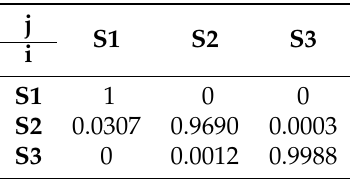
Table 2. Example of a transition matrix for a washing machine derived by taking into account user presence information.